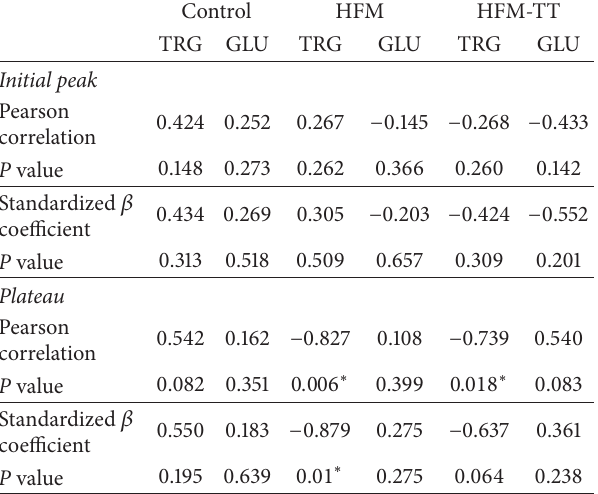
Table 4: Linear regression for the correlation between %CVC max and blood triglycerides and blood glucose for both the initial peak and plateau phase of cutaneous thermal hyperemia. HFM: high fat meal; HFM-TT: high fat meal + thermotherapy; TRG: blood triglycerides; GLU: blood glucose. ∗ indicates statistically significant Pearson correlation and standardized beta